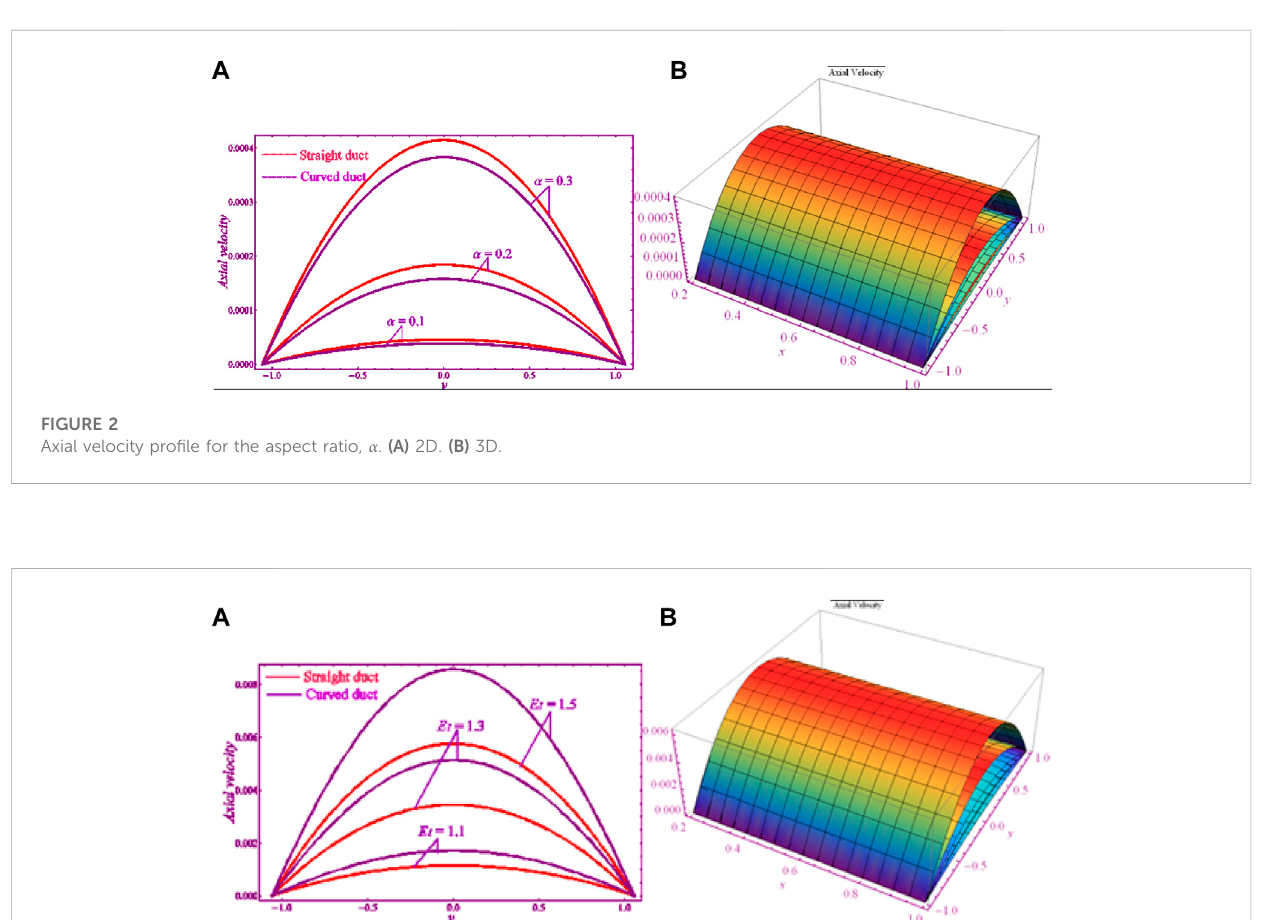
Axial velocity pro fi le for mass per unit area, E 1 . (A) 2D. (B) 3D.